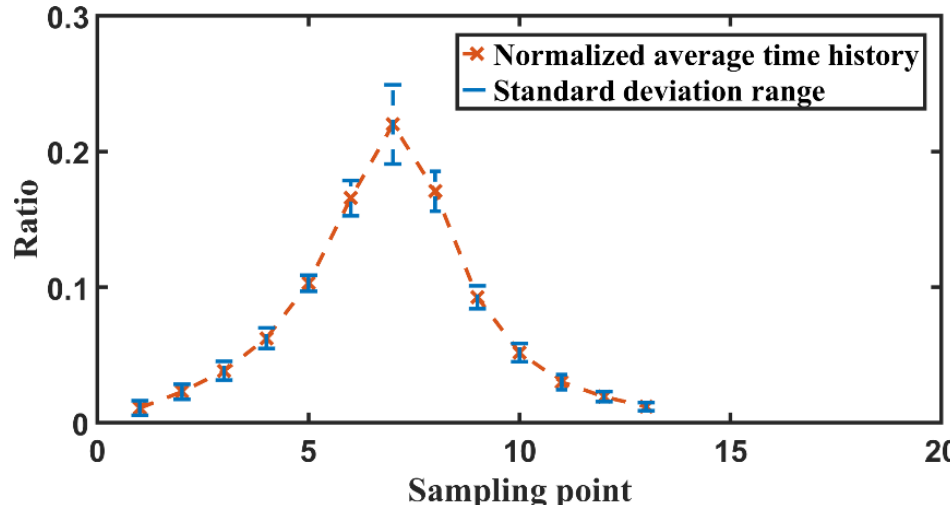
Figure 18. Normalized average time history of impact load.